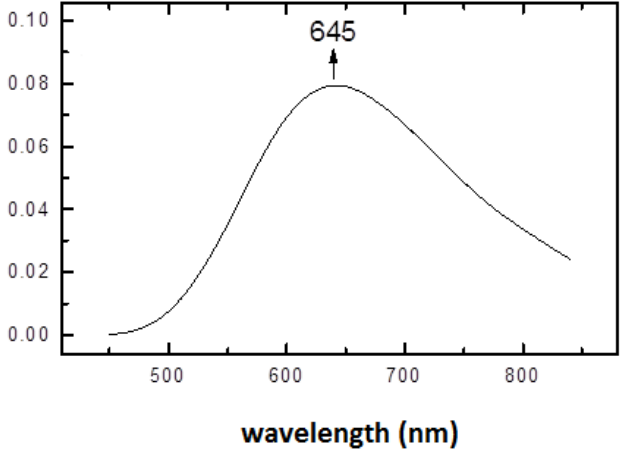
Figure 5. The structure of the Cu(L-His)